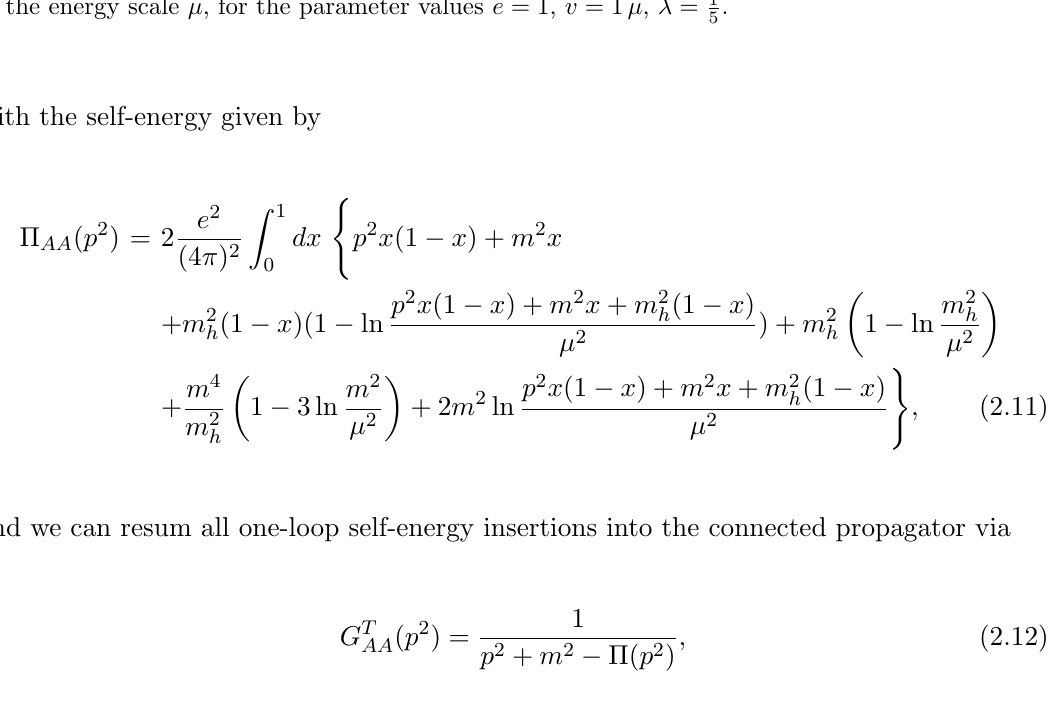
Figure 1 . Resummed photon propagator, with all quantities given in units of appropriate powers of the energy scale (cid:22) , for the parameter values e = 1, v = 1 (cid:22) , (cid:21) = 1